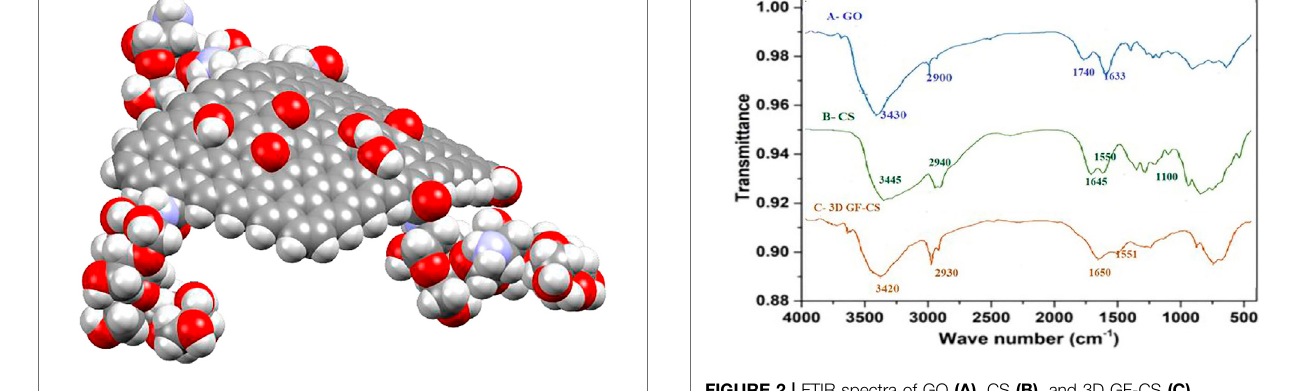
FIGURE 1 | Optimized geometry of the 3D GF-CS model.